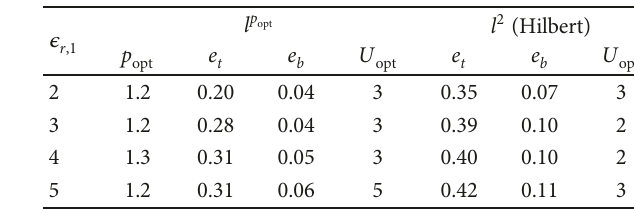
) and number of outer t / b versus ϵ with p = p and p = 2 opt r ,1 opt